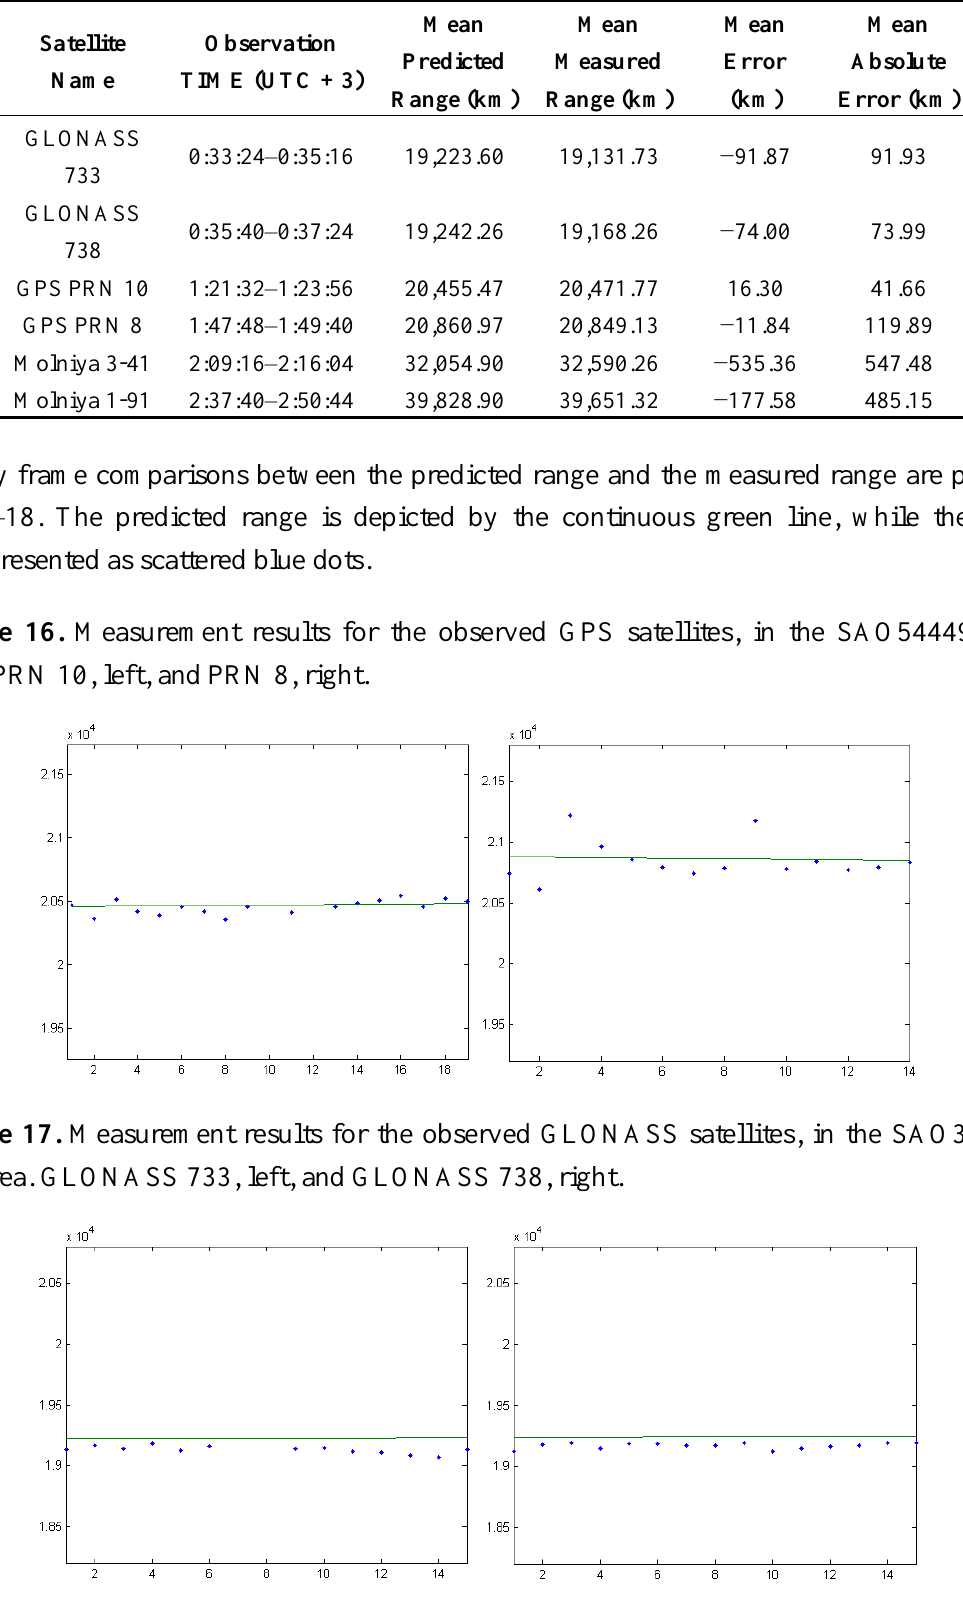
Table 2. Measurement results for the observed satellites.